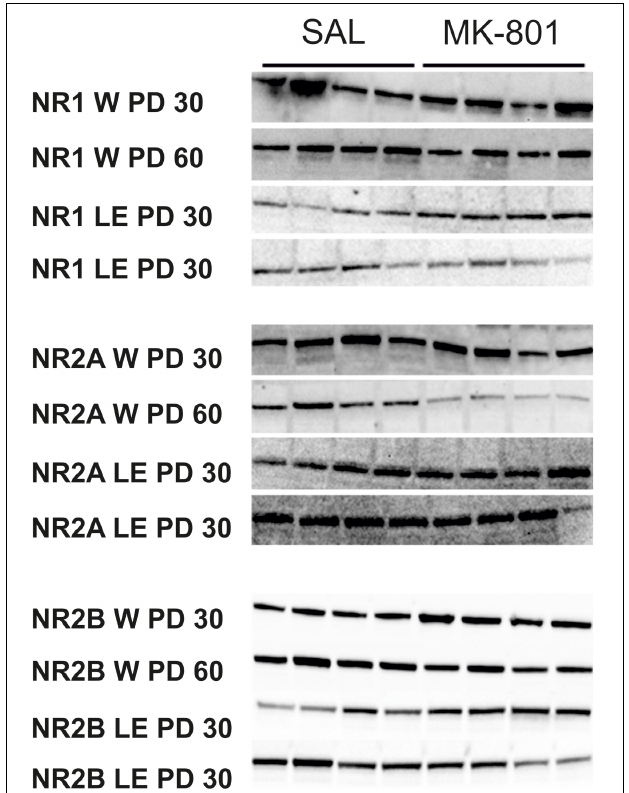
FIGURE 6 | Examples of Western blot of the hippocampal supernatant showing expression of the NMDA subunits (GluN1 ∼ 100 kDa, GluN2A ∼ 170 kDa, GluN2B ∼ 180 kDa) at two age intervals (PD 30, PD 60) in Long-Evans and Wistar rats. Control group samples are in columns 1–4 and MK-801 samples are in the columns